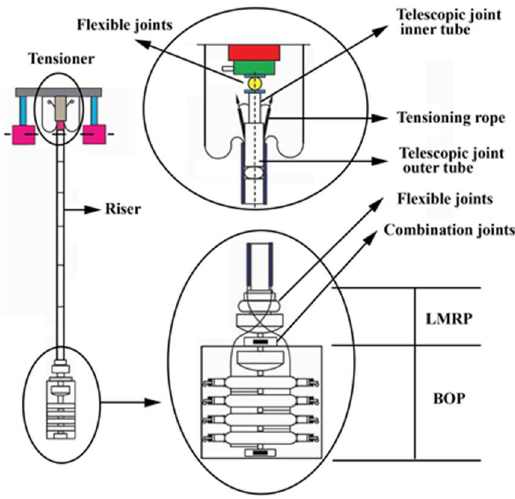
Figure 1. Schematic diagram of the deepwater drilling riser system [1].